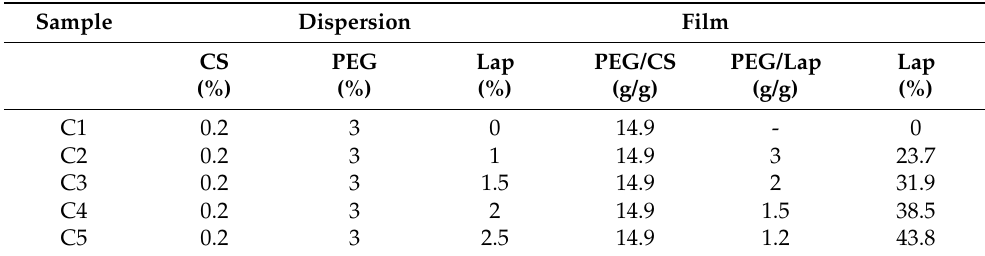
Table 1. The composition of the investigated